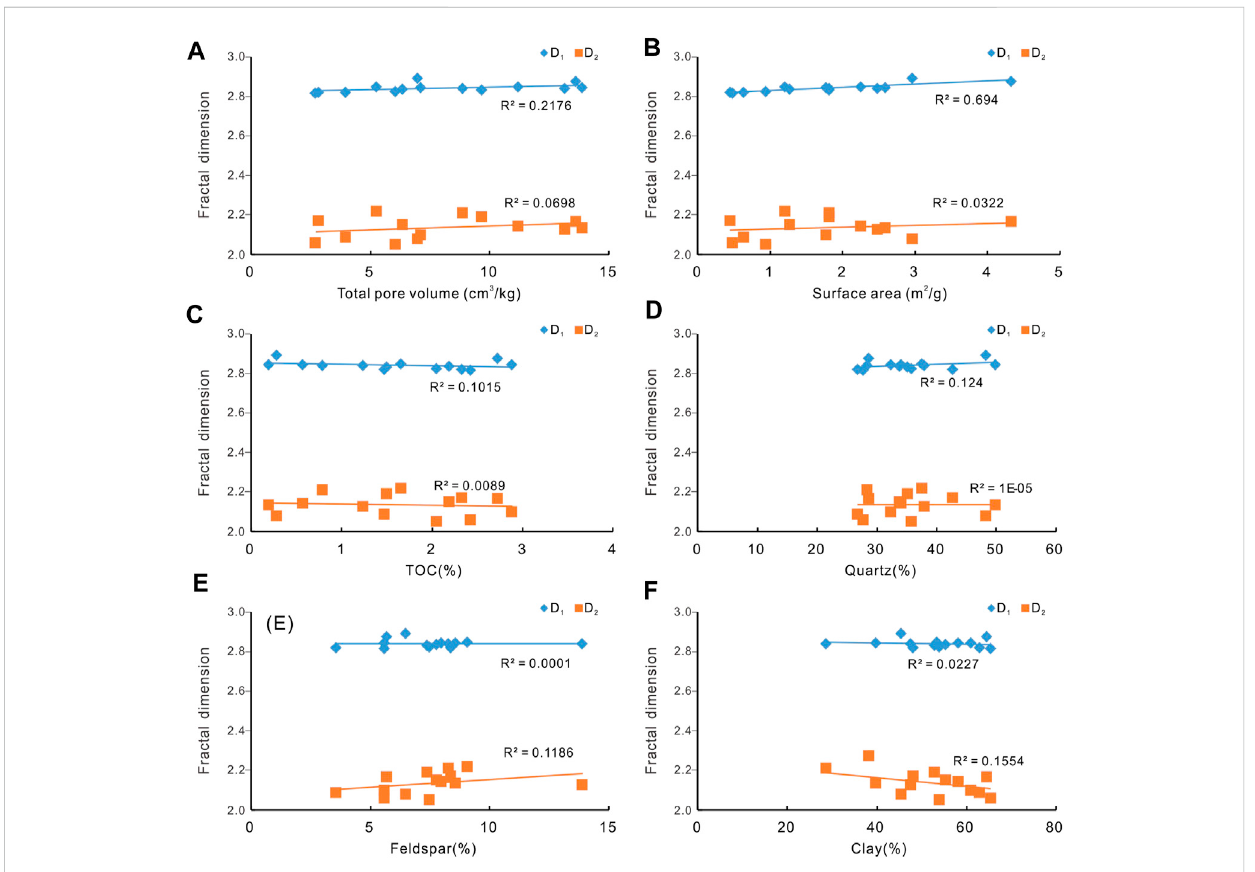
FIGURE 10 Correlation between the shale mineral composition and fractal dimension of the Jurassic Lianggaoshan Formation lacustrine shale. (A) Correlation between fractal dimensions and total pore volumn; (B) Correlation between fractal dimensions and surface area; (C) Correlation between fractal dimensions and TOC content; (D) Correlation between fractal dimensions and quartz content; (E) Correlation between fractal dimensions and feldspar content; (F) Correlation between fractal dimensions and clay